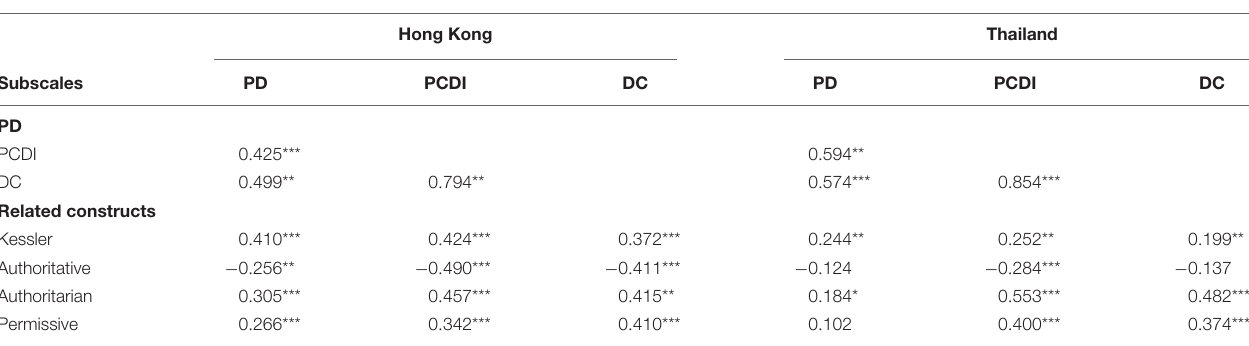
TABLE 4 | Correlations between subscales and related